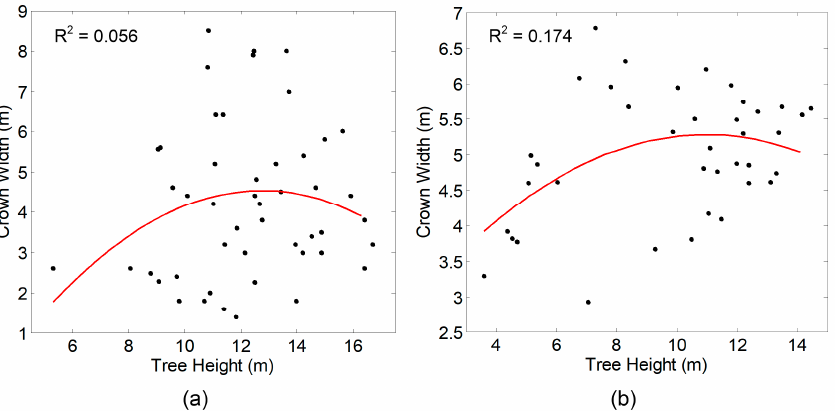
Figure 7. Quadratic regression model between tree height and crown diameter data derived from test site 1 ( a ) and test site 2 ( b ).